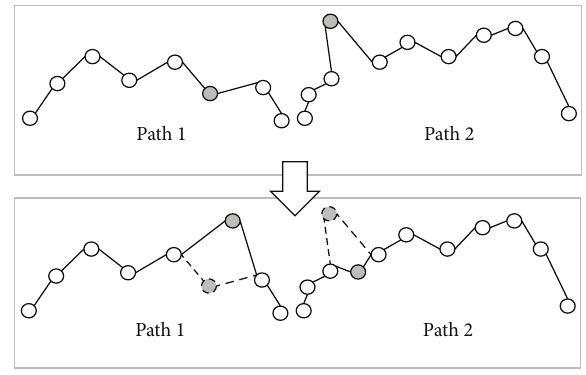
Figure 12: Apply one point swap crossover operator to generate offspring. Table 2: Comparison in performance among the proposed hybrid approach, PSO, and GA for test environment I.